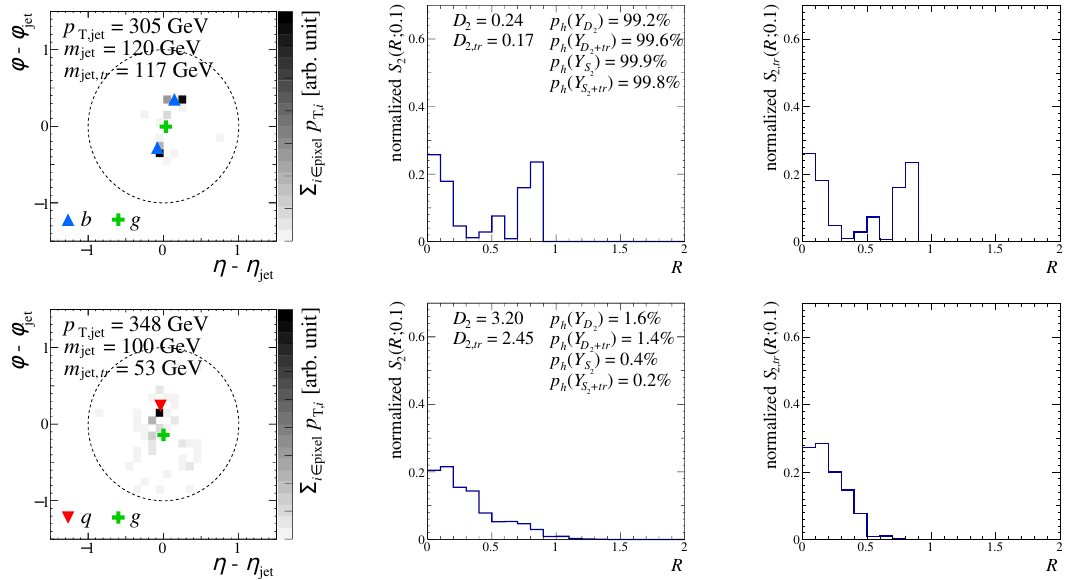
Figure 2 . The pixelated jet image (left), two-point spectrum S 2 ( R ; 0 : 1) (center), and the trimmed spectrum S 2 ( R ; 0 : 1) (right) of a typical Higgs jet (top) and a typical quark jet (bottom). The sum of the bins of each spectrum is normalized to 1. The red reversed triangles, blue triangles, and green plus symbols in the pixelated jet images indicate direction of light quarks, b quarks and gluons